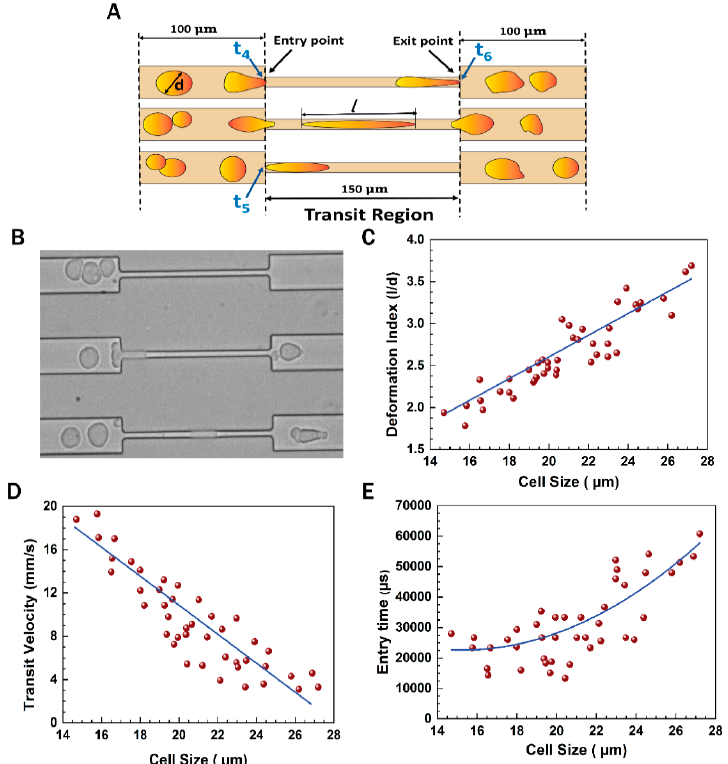
Figure 5. Flow dynamics of cells through a constricted 7 µ m channel. ( A ) Stepwise motion of the cells through the constricted channel; ( B ) microscopic image of cells passing through constricted microchannel; ( C – E ) deformation index, entry time, and transit velocity of the cells through the 7 µ m constricted passage, respectively.